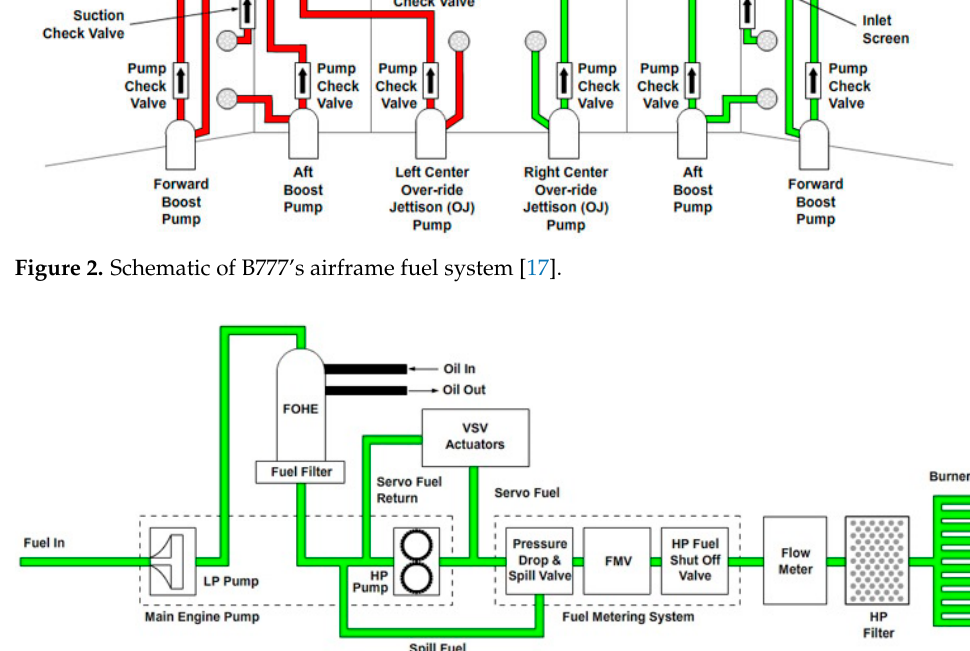
Figure 3. Schematic of B777’s engine fuel system [17].